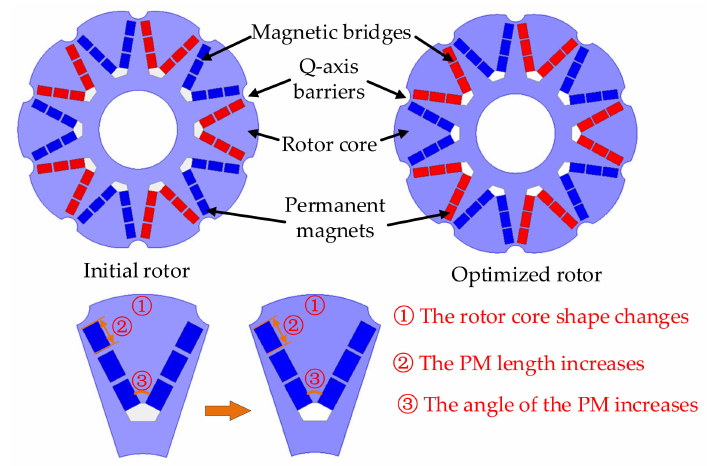
Figure 8. The rotors of the initial and optimized motors.